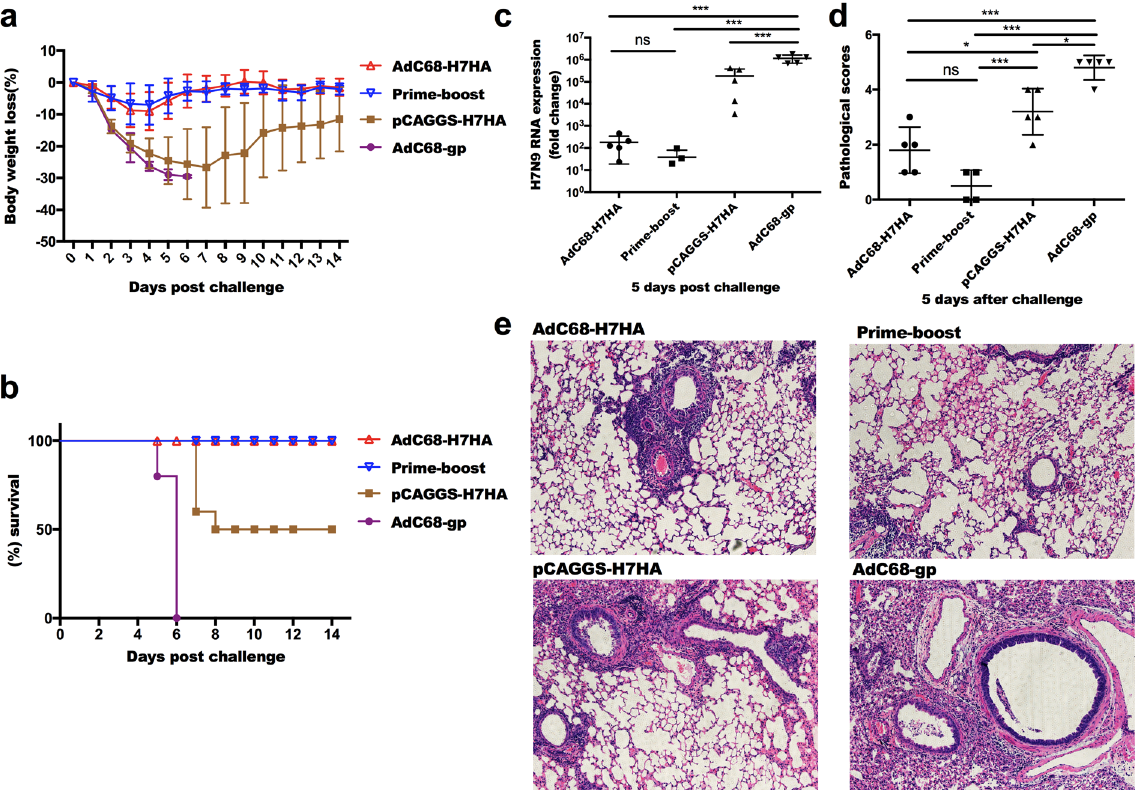
Figure 4. A single immunization with AdC68-H7HA or DNA prime-adenovirus boost regimen protected mice from lethal H7N9 viral challenge. Eight weeks after immunization, mice were challenged with 3.5 × 10 5 TCID50 of H7N9 virus, after which body weights and survival rates were monitored for 14 days. ( a ) Body weight changes. ( b ) Survival rates. No significant difference was observed between the prime-boost group and the AdC68-H7HA group. Results of the prime-boost group and the AdC68-H7HA group were significantly different compared with those of the AdC68-gp group (p = 0.00001) and the DNA-only group (p = 0.03). ( c ) H7N9 viral loads in mouse lungs at 5 days post-challenge. Five days after challenge, the mice were sacrificed and the lungs were harvested and homogenized to extract the total RNA. Then, real-time PCRs were performed. ( d ) Pathological scores of the lungs at 5 days after challenge. ( e ) Lung sections were stained with H&E to assess inflammation and tissue damage on day 5 after challenge. The error bars represent the SD. *** p < 0.001; ** p < 0.01; * p < 0.05; ns, not